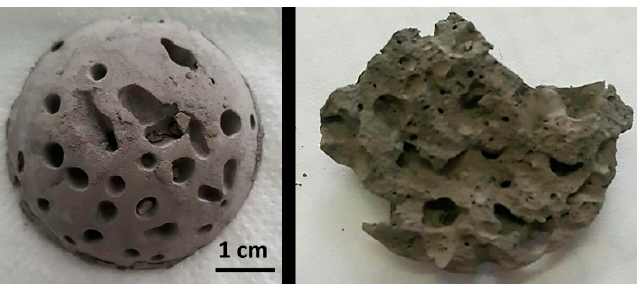
Figure 3. Porous Ti green sample, (left) dome shaped by gelation and drying and (right) a detail of the internal porous structure observed after breaking apart the sample.